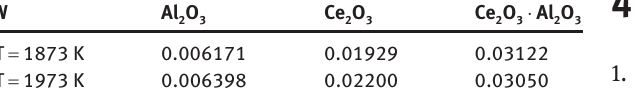
Table 3: The mass action concentration of Ce 2 O 3 , Al 2 O 3 and